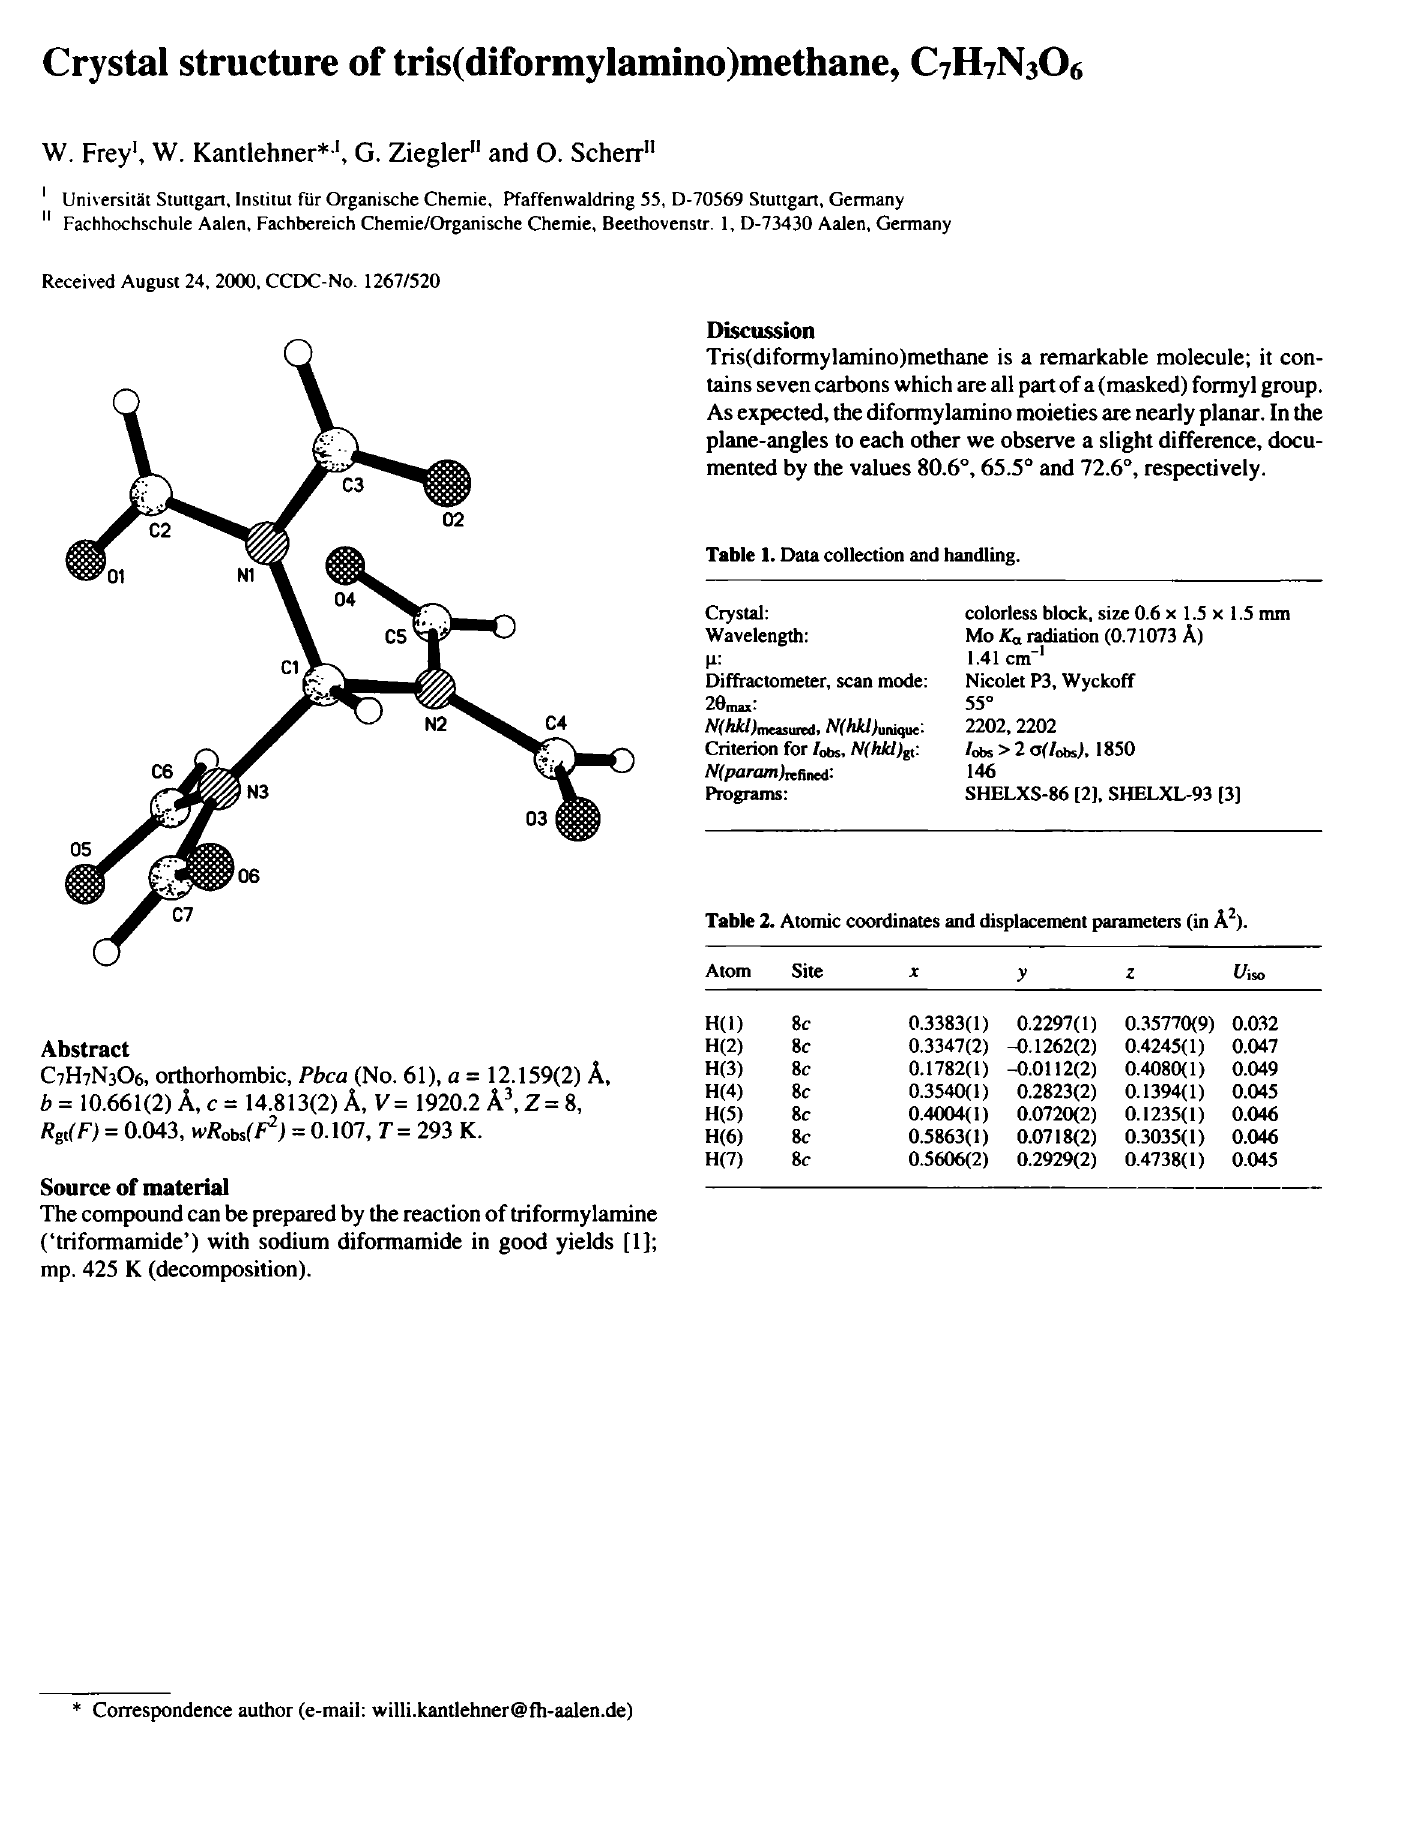
Table 1. Data collection and handling.